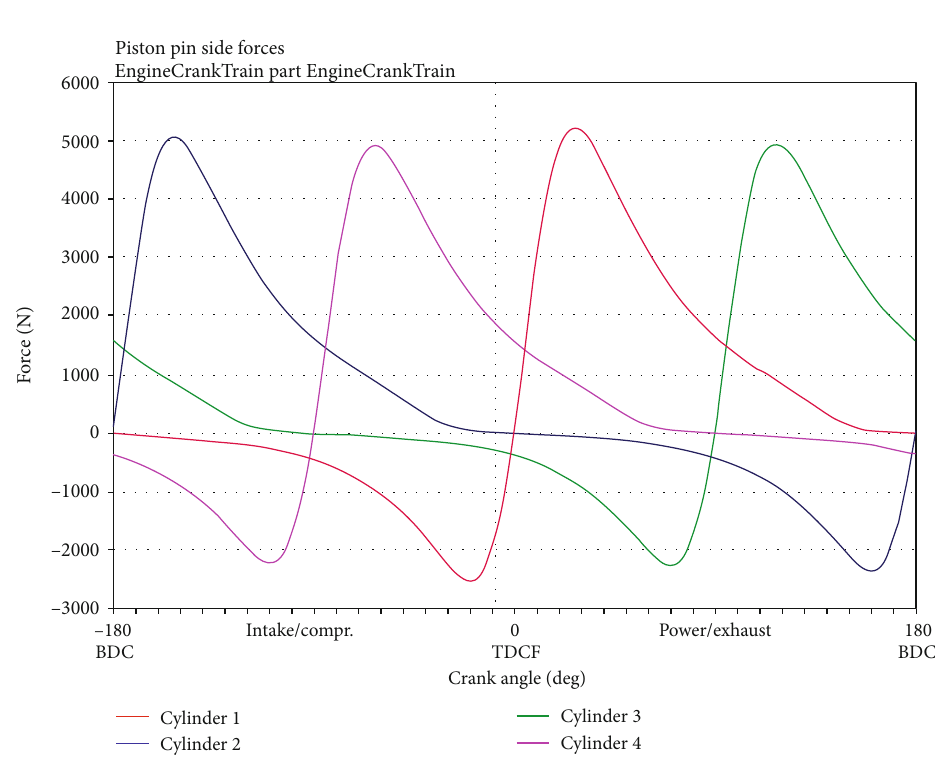
Figure 4: Piston pin side force curve at 2700